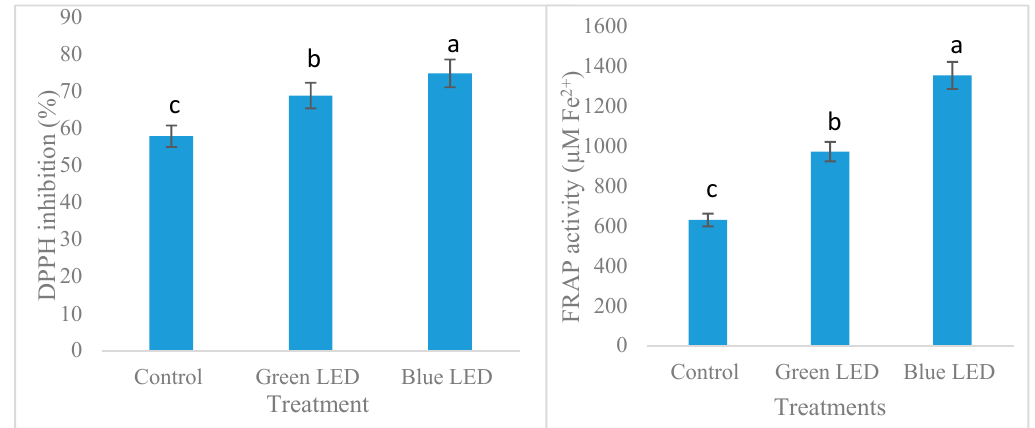
Figure 3. Antioxidant capacity (DPPH and FRAP) of soybean sprout under different light treatment. The values are mean ± SE. ( n = 3). DPPH, 2-diphenyl-1 picryl hydrazyl; FRAP, Ferric Reduction Antioxidant Power; SE, standard deviation. Different lowercase letters within the row indicates significant differences ( p < 0.05) according to ANOVA.